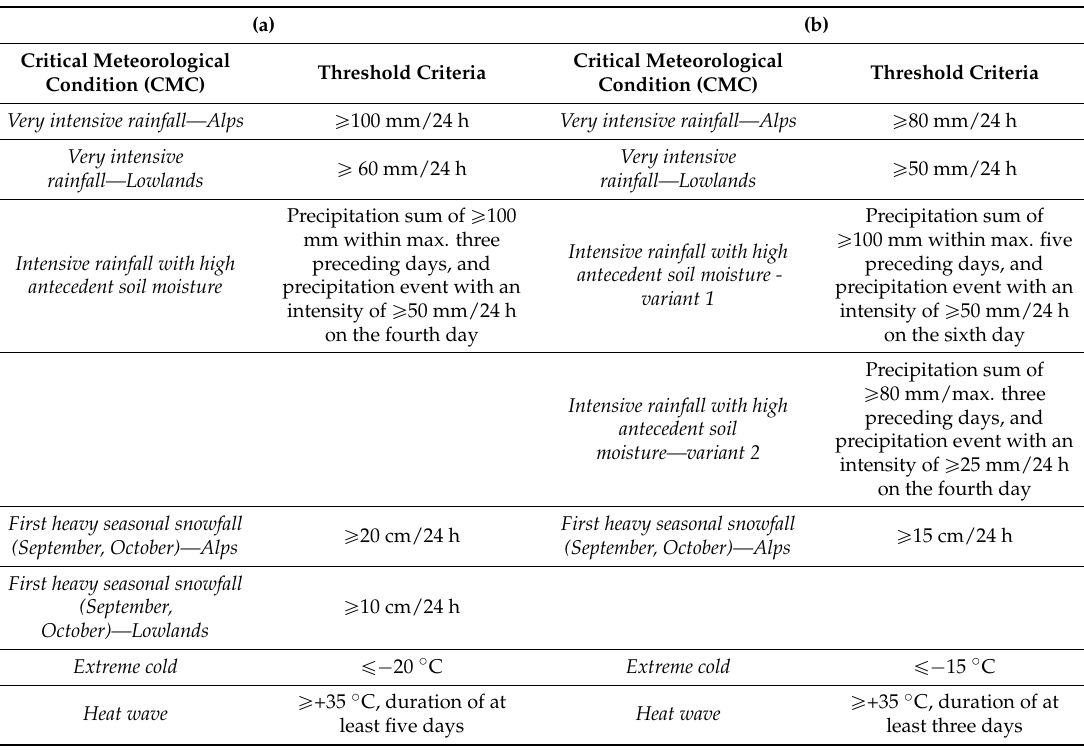
Table 1. Section ( a ) shows the original threshold criteria for Critical Meteorological Conditions (CMCs) for railway transportation in Austria. In Section ( b ), the modified threshold criteria used for the sensitivity analysis are